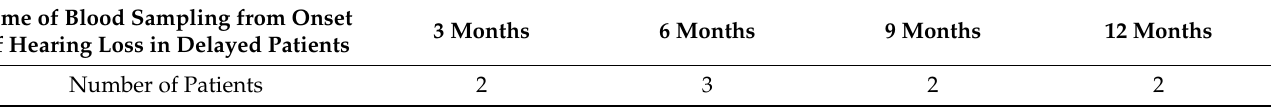
Table 1. Time of blood sampling from onset of the disease in delayed group